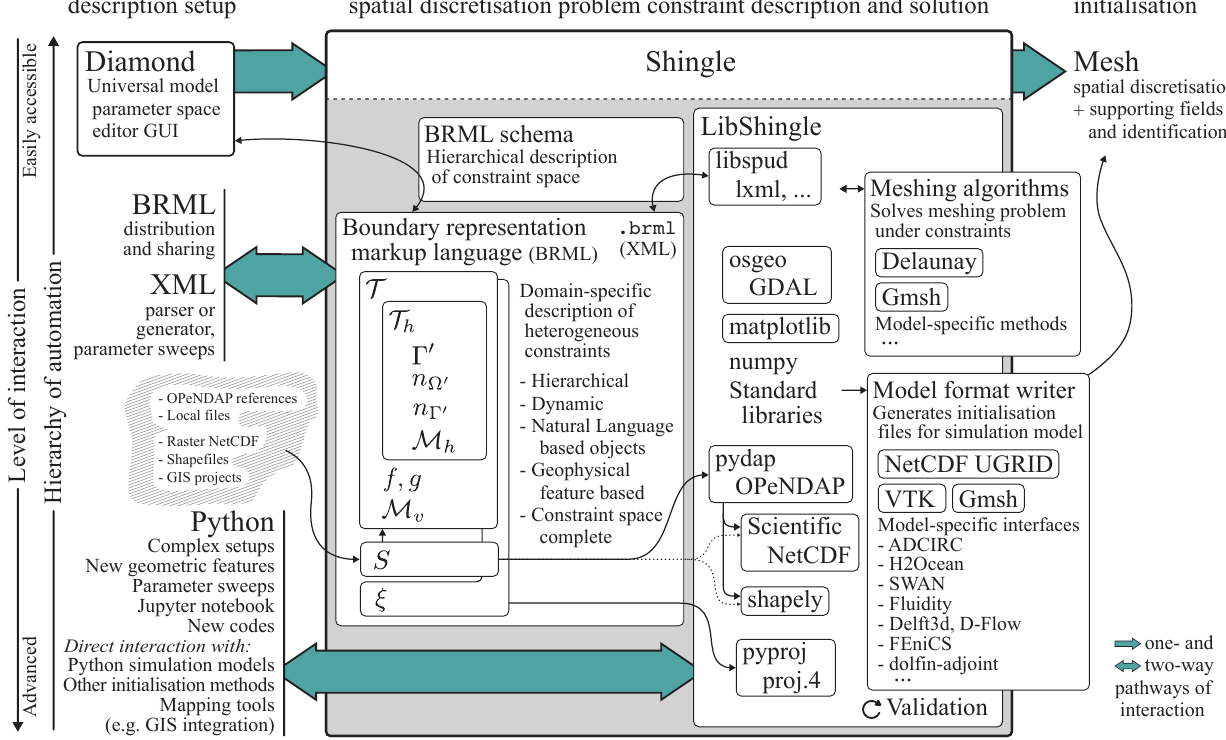
Figure 2. A schematic illustrating the generalised approach to flexible unstructured mesh specification and generation for geophysical mod- els. The hierarchy of automation (tenet 7) is highlighted, from a relatively simple high-level interaction, Diamond GUI ↔ Shingle → Mesh, to complex low-level development communicating with the LibShingle library. Nomenclature defined in Sect.